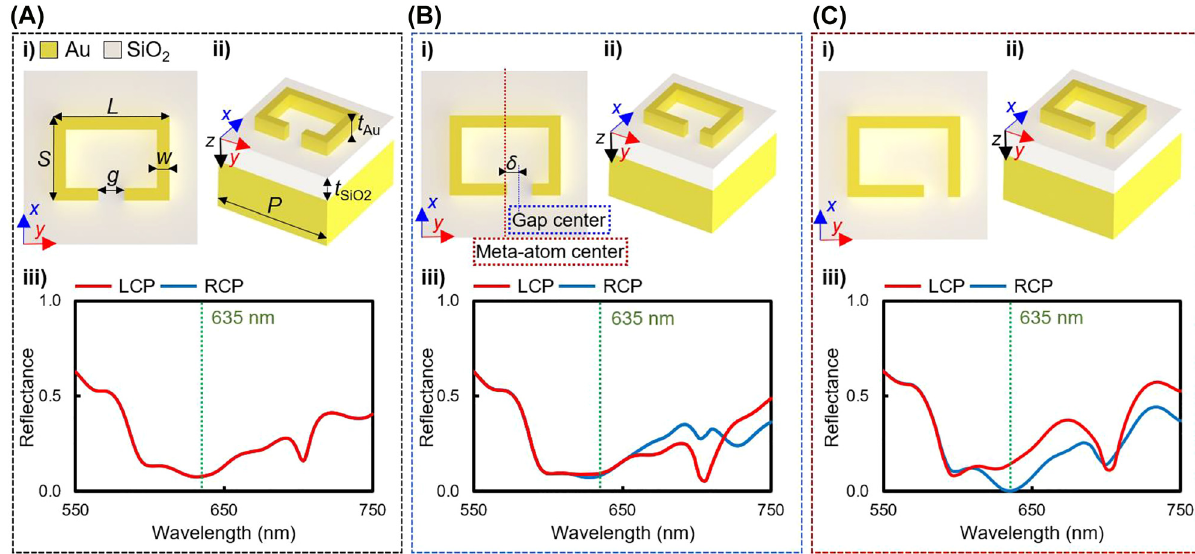
Figure 2: Effect of gap-shiftonchiro-optical responses insplit-ringresonators(SRR).Geometricparametersof thegap-shiftedSRRs are long- axis length L , short-axis length S , gap g , gold width w , Au thickness t Au , and SiO 2 thickness t SiO2 , gap displacement δ , and periodicity P . Geometric parameters are L = 345 nm, S = 242 nm, g = 58 nm, w = 83 nm, t Au = 57 nm, t SiO2 = 308 nm, and p = 450 nm. Simulated re fl ectance spectraofthreeSRRs,thathavegapsin(A(i))Thecenter( δ =0nm)(B(i))Themid-right( δ =30nm),and(C(i))Theright( δ =60.5nm).Reddotted line: center of unit cell; blue dotted line: center of gap. (i) Top-view, (ii) tilted view of unit cells, and (iii) simulated re fl ectance under LCP and RCP,